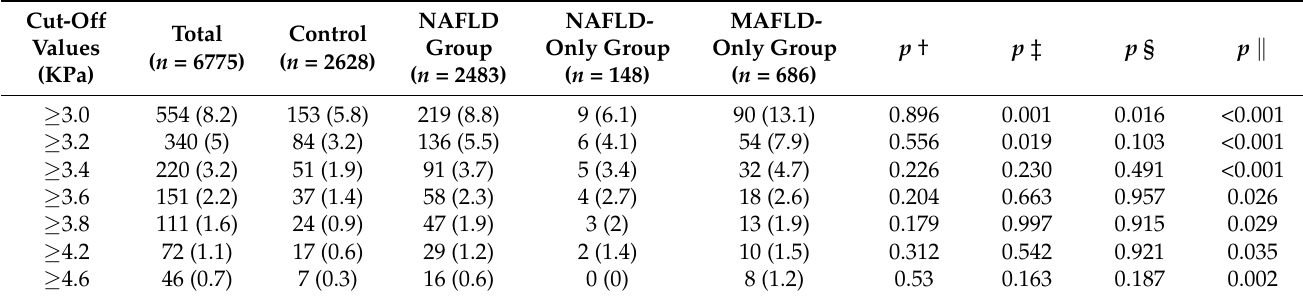
Table 2. The prevalence of hepatic fibrosis at various cut-off